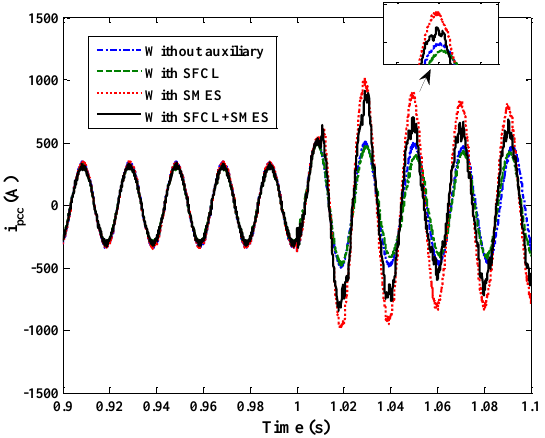
Figure 13. Characteristics of the PCC current under the symmetrical fault.